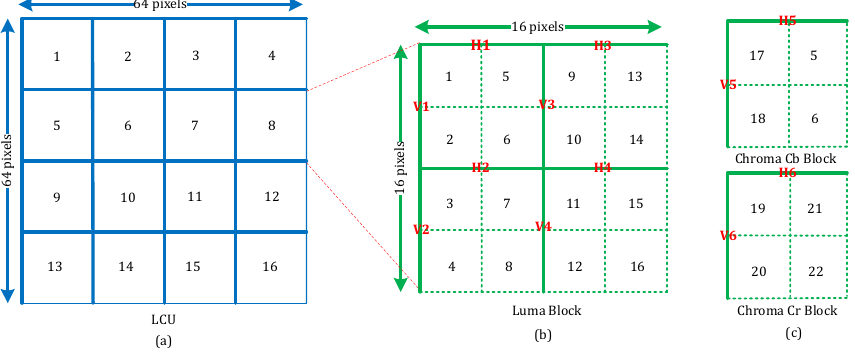
Figure 4. ( a ) Sequence of read for an LCU; ( b , c ) sequence of read for a 16 × 16